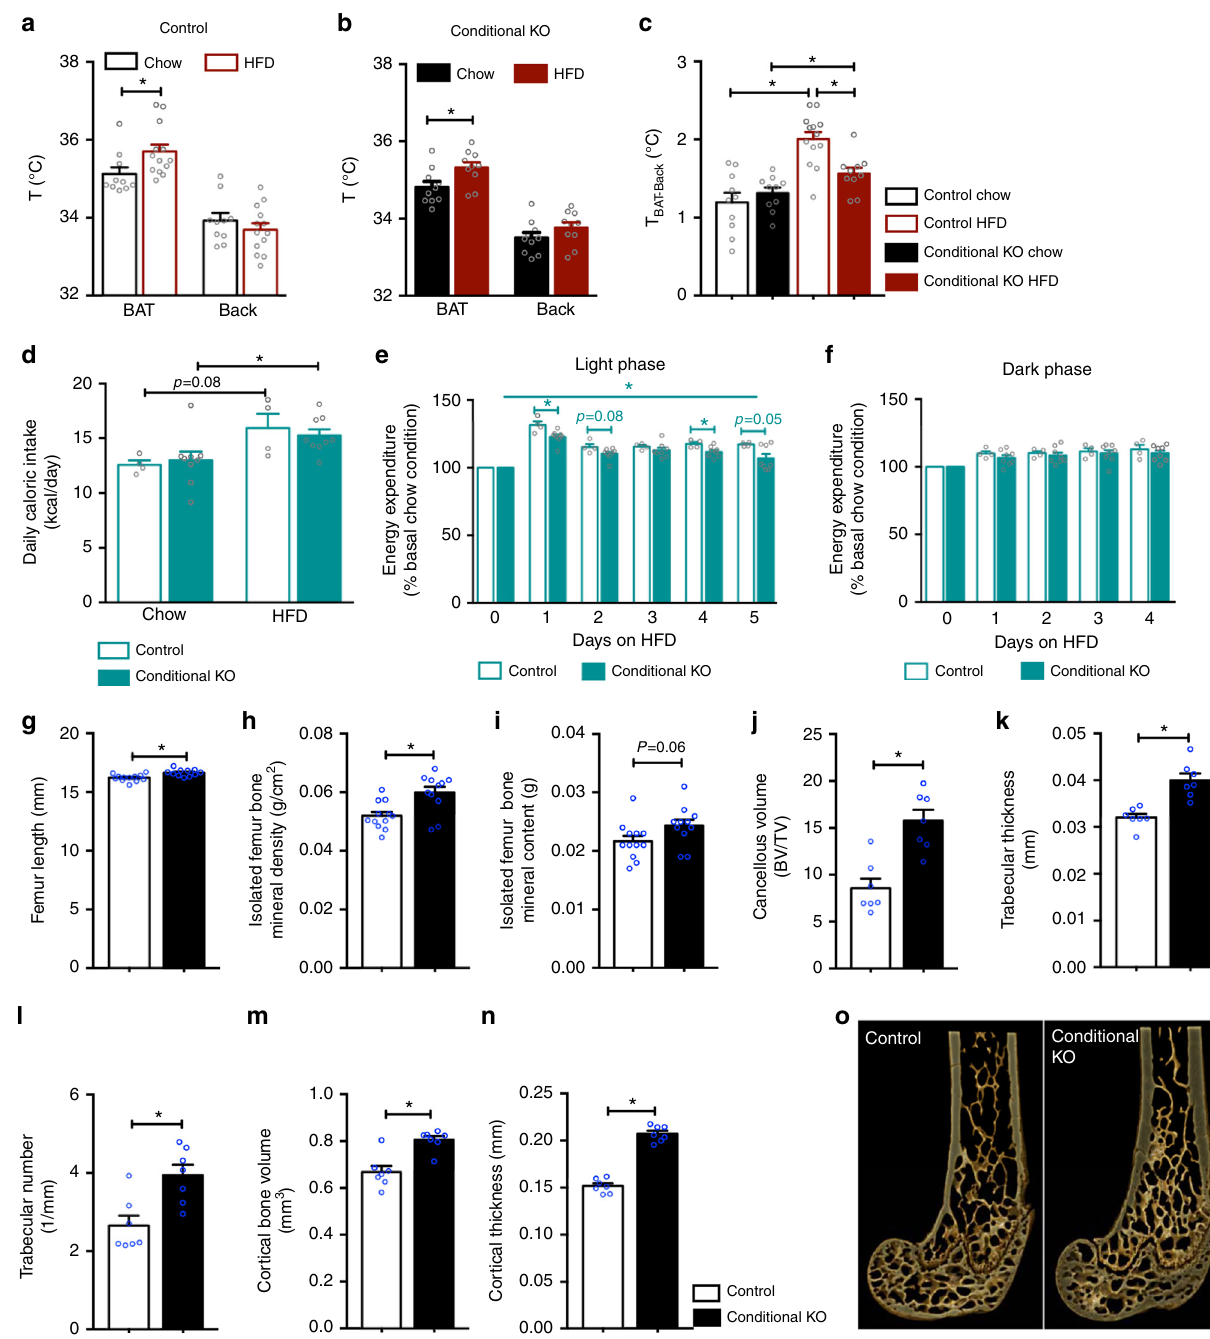
Fig. 9 Impaired diet-induced thermogenesis in male mice with conditional deletion of Npffr2 in Npy neurons during the early stage of HFD. a , b , c Skin temperature at lumbar back ( T Back ) and brown adipose tissue ( T BAT ), and temperature difference ( Δ T BAT-Back ) between T BAT and T Back assessed by infrared imaging in freely moving control and conditional KO mice on chow or 10 days of HFD. Control: chow n = 11, HFD n = 13; Conditional KO: chow n = 10, HFD n = 10. d Energy intake in control and conditional KO mice under chow and during the fi rst 5 days of HFD. Control n = 4, conditional KO n = 8. e , f Average energy expenditure during the light and dark phases over the fi rst 5 days of HFD relative to chow condition in control and conditional KO mice. N values as in d . g – i The length, bone mineral density and content of isolated femora of control and conditional KO mice at 16 weeks of age. Control n = 12, conditional KO n = 11. j , k , l Cancellous bone volume, trabecular thickness and trabecular number of the distal femur in control and conditional KO mice. N = 7 per group. m , n Cortical bone volume and cortical thickness of the distal femur in control and conditional KO mice. N = 7 per group. o Representative photomicrographs of the distal femoral metaphysis in control and conditional KO mice. Gene deletion was induced by tamoxifen at 6 weeks of age (Conditional KO). Male Npy creER2/ + ,Npffr2 lox/lox mice without tamoxifen and Npy creER2/ + ,Npffr2 lox/ + mice treated with tamoxifen were used as controls. Data are mean ± SEM. Repeated-measures ( e , f ) or one-way ANOVA ( a – d , g – n ) was used to determine difference among groups. ∗∗ p < 0.05 as indicated by